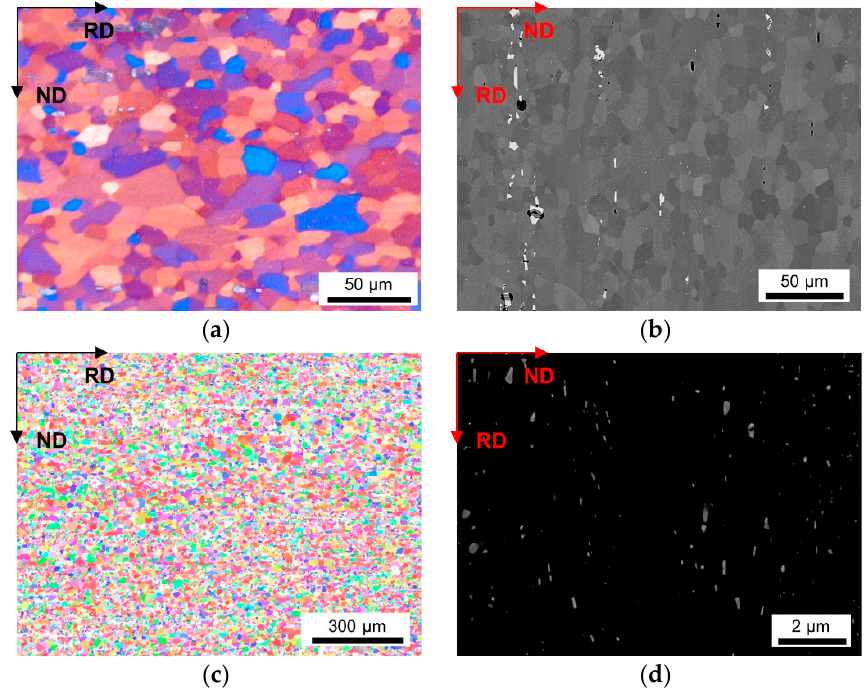
Figure 5. Microstructure of the soft annealed HFe-HMn cast under S-C condition, homogenized at 500 °C and cold rolled to a CRD of 63%. ( a ) LOM. ( b ) BSE image. ( c ) EBSD IPF map in RD–ND plane. ( d ) BSE micrograph showing dispersoids.